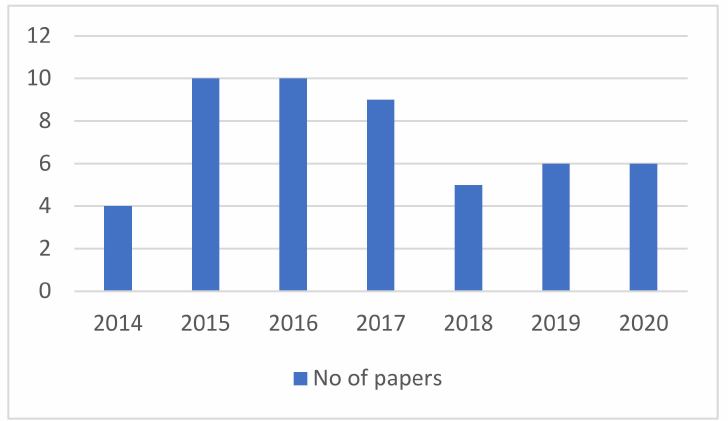
Figure 1. Publication